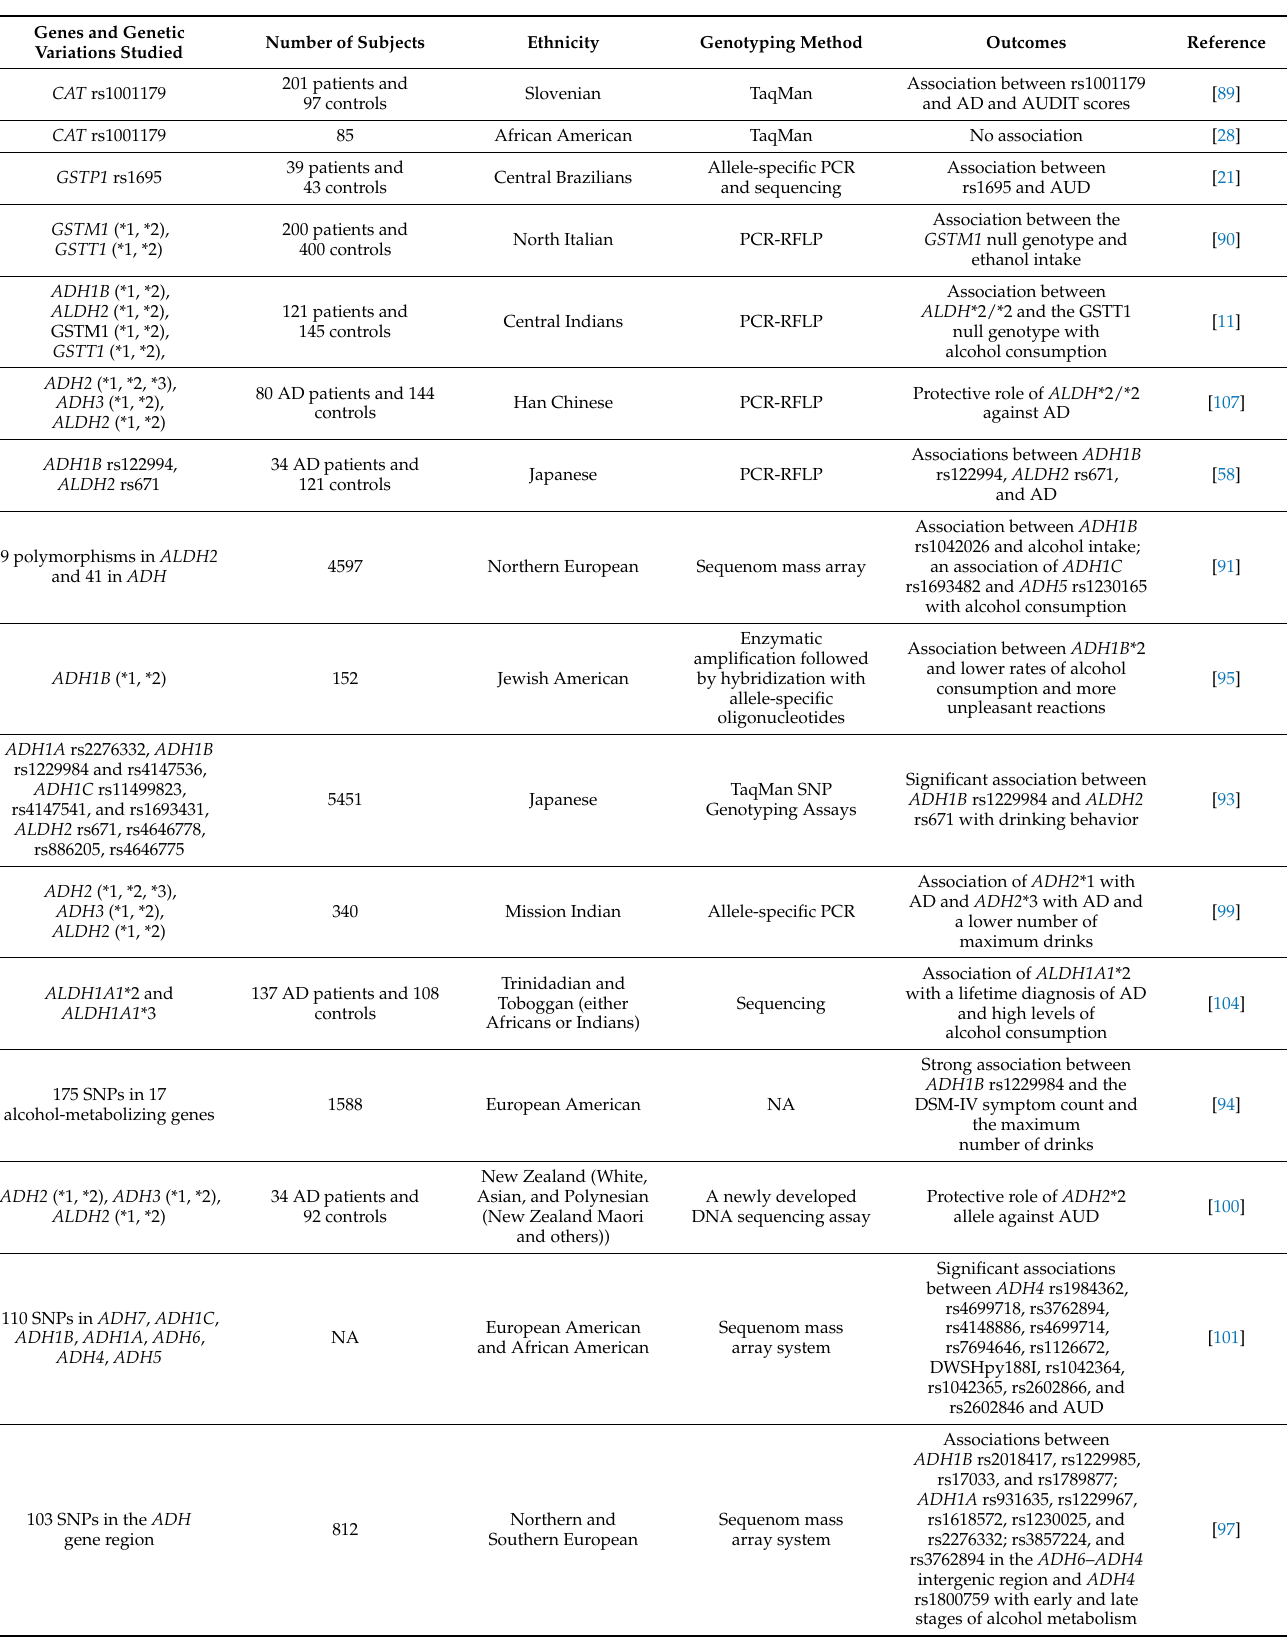
Table 3. Candidate gene studies in AUD that focused on associations with polymorphisms in oxidative stress-related